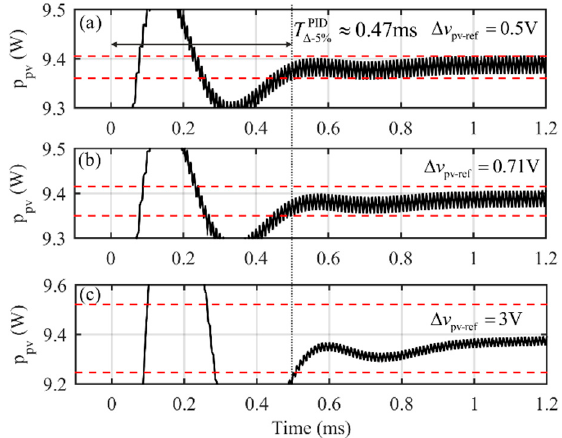
Figure 17. The simulated PVG-power transients when the PVG-voltage-reference step size is ( a ) 0.5 V, ( b ) 0.71 V, and ( c ) 3 V. The converter operates all the time in CCM.